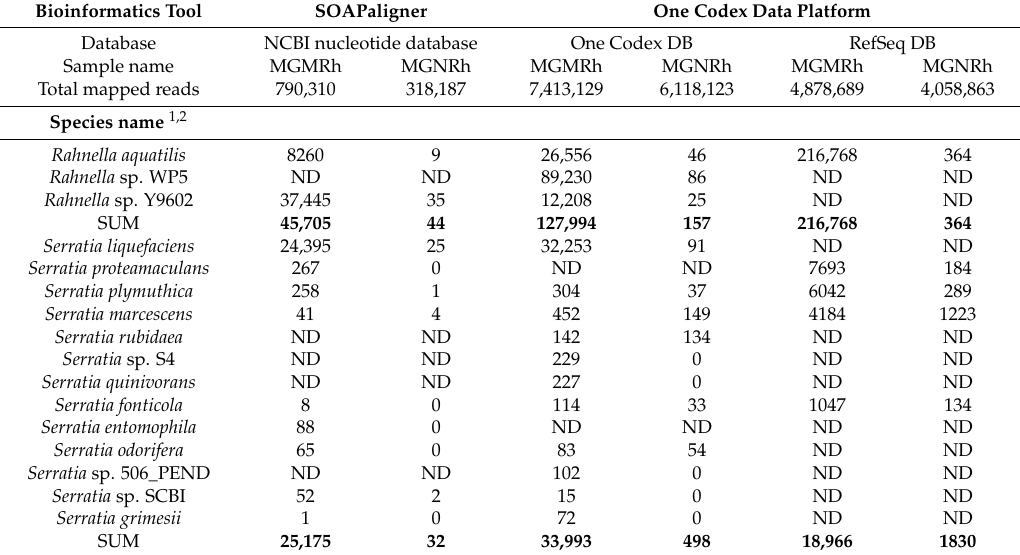
Table 2. Identification and comparison of rhizobacterial species of Rahnella and Serratia in MGMRh and MGNRh by shotgun metagenomic approaches.